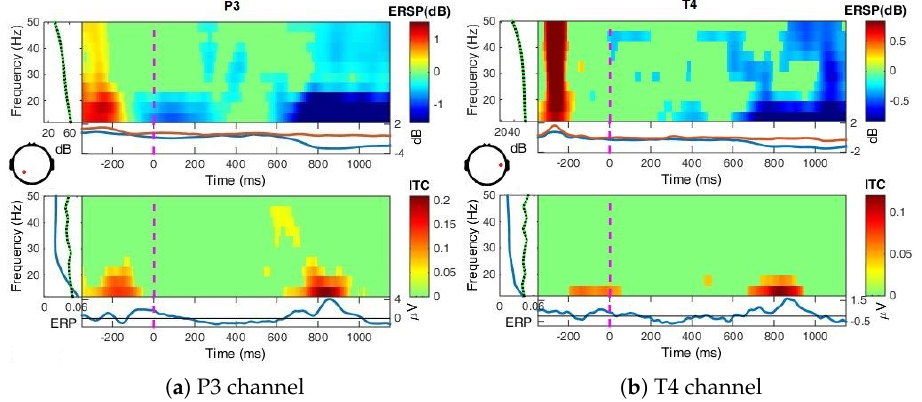
Figure A4. ERSP over all blocks for Uni perception at P3 and T4, bootstrap significance level α = 0.01. Nat perception (Figure A5): The desynchronizations are stronger and extended in frequency and time, more pronounced in the γ frequency (over 30 Hz) for the T4 channel as compared to Uni image perception. For parietal site, lower ERDs are observed after 600 ms including also γ band. Considering ITC, no phase synchronization between trials is observed for the first group of P200–P300 peaks, since it includes the thought process of perception which is different between image to image.